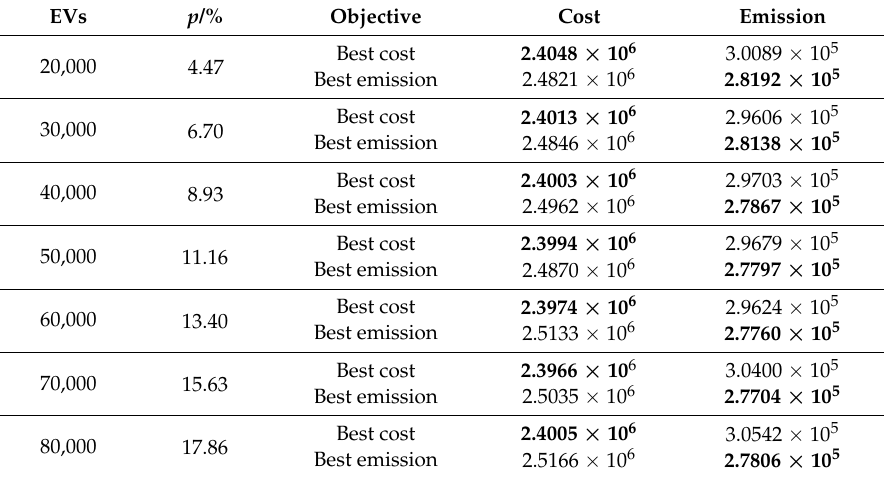
Table 9. Extreme solutions with different penetrations at two times wind